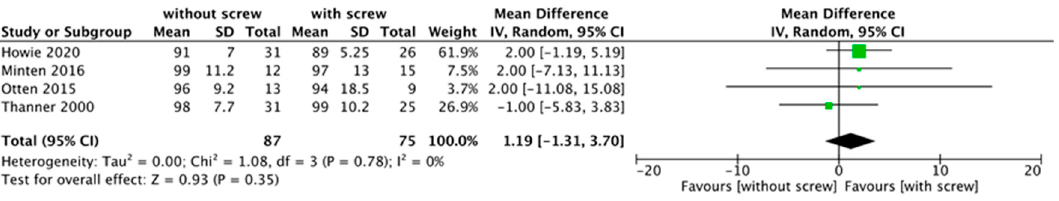
Figure 5. Forest plot of Harris Hip Score in the without and with screw fixation groups [10,11,13,14]. (IV: inverse variance method)